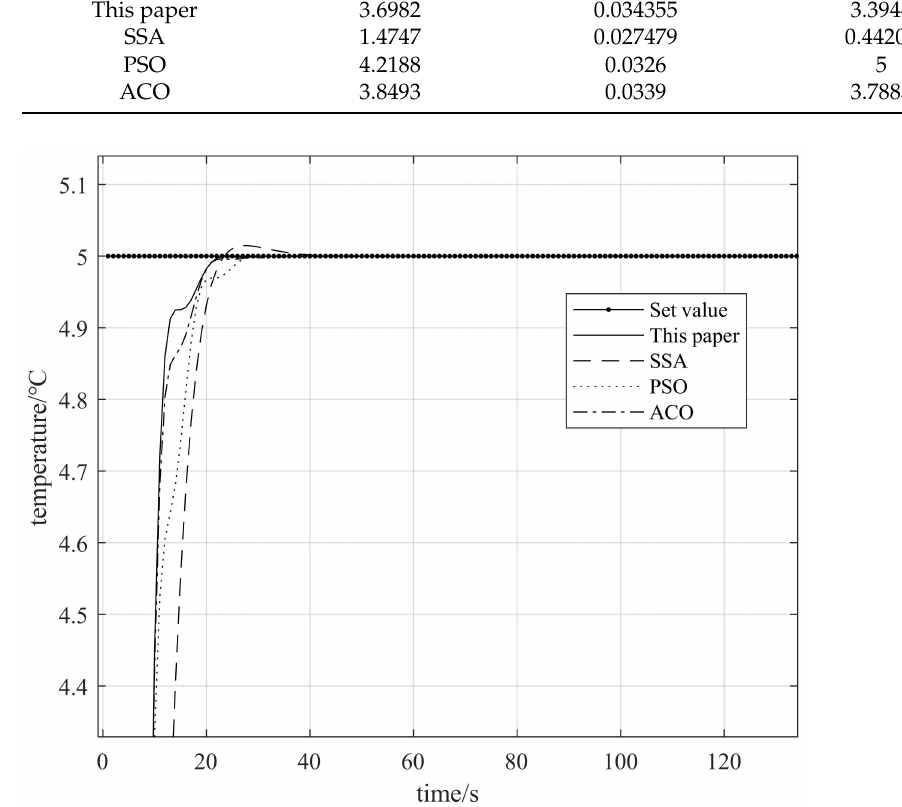
Figure 2. Simulation diagram of the